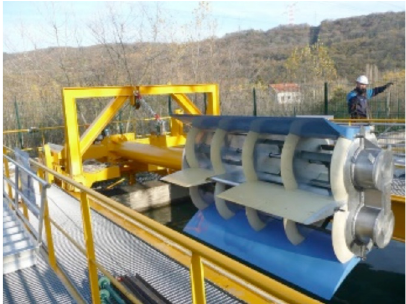
Fig. 5. A prototype HPS before being